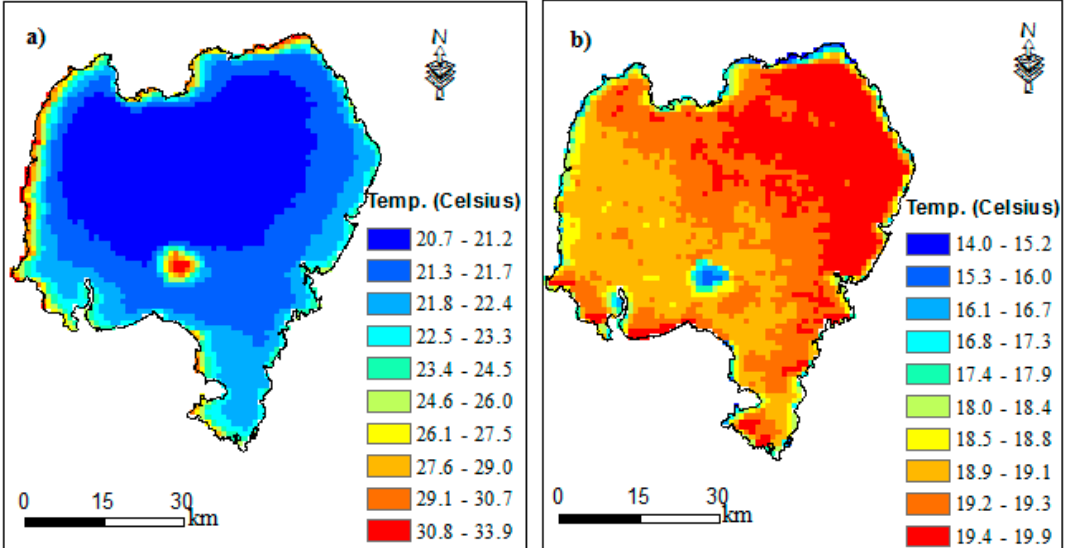
Figure 9. Average annual day and night-time water temperature for the period 2010–2016. ( a ) Daytime average annual water temperature and ( b ) night-time average annual water temperature.